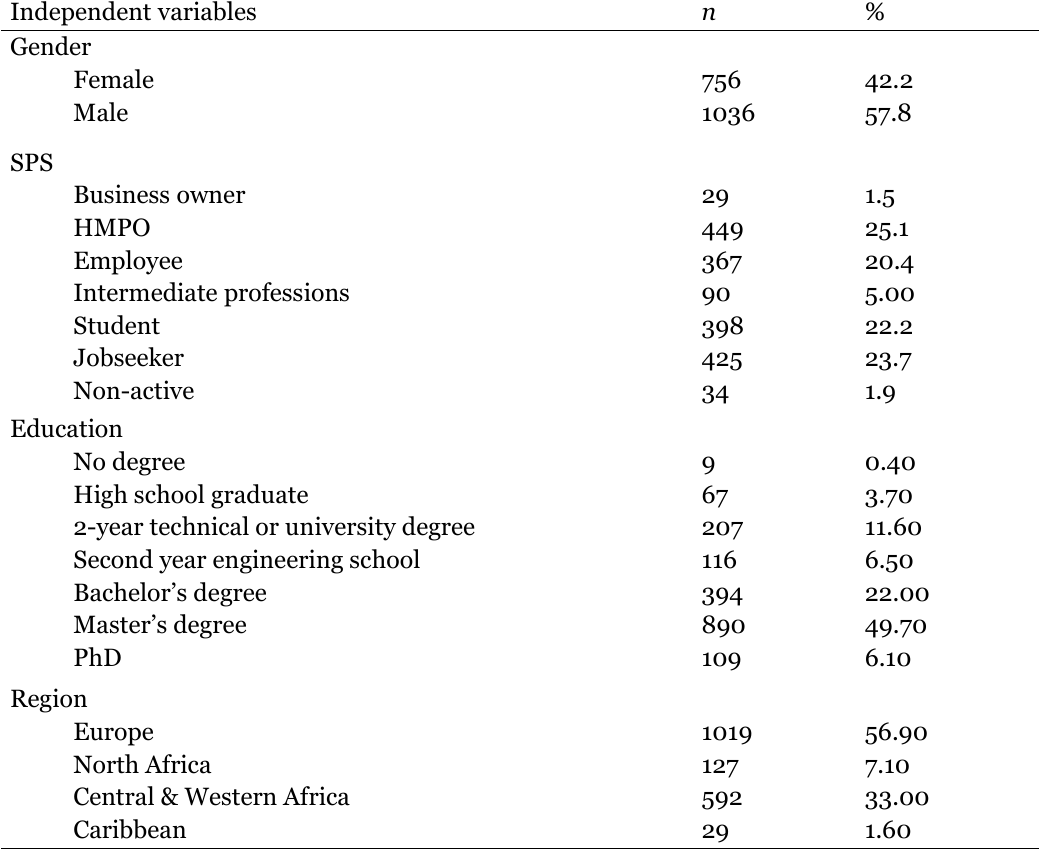
Study Participant Demographics (N = 1,792; AC: n =